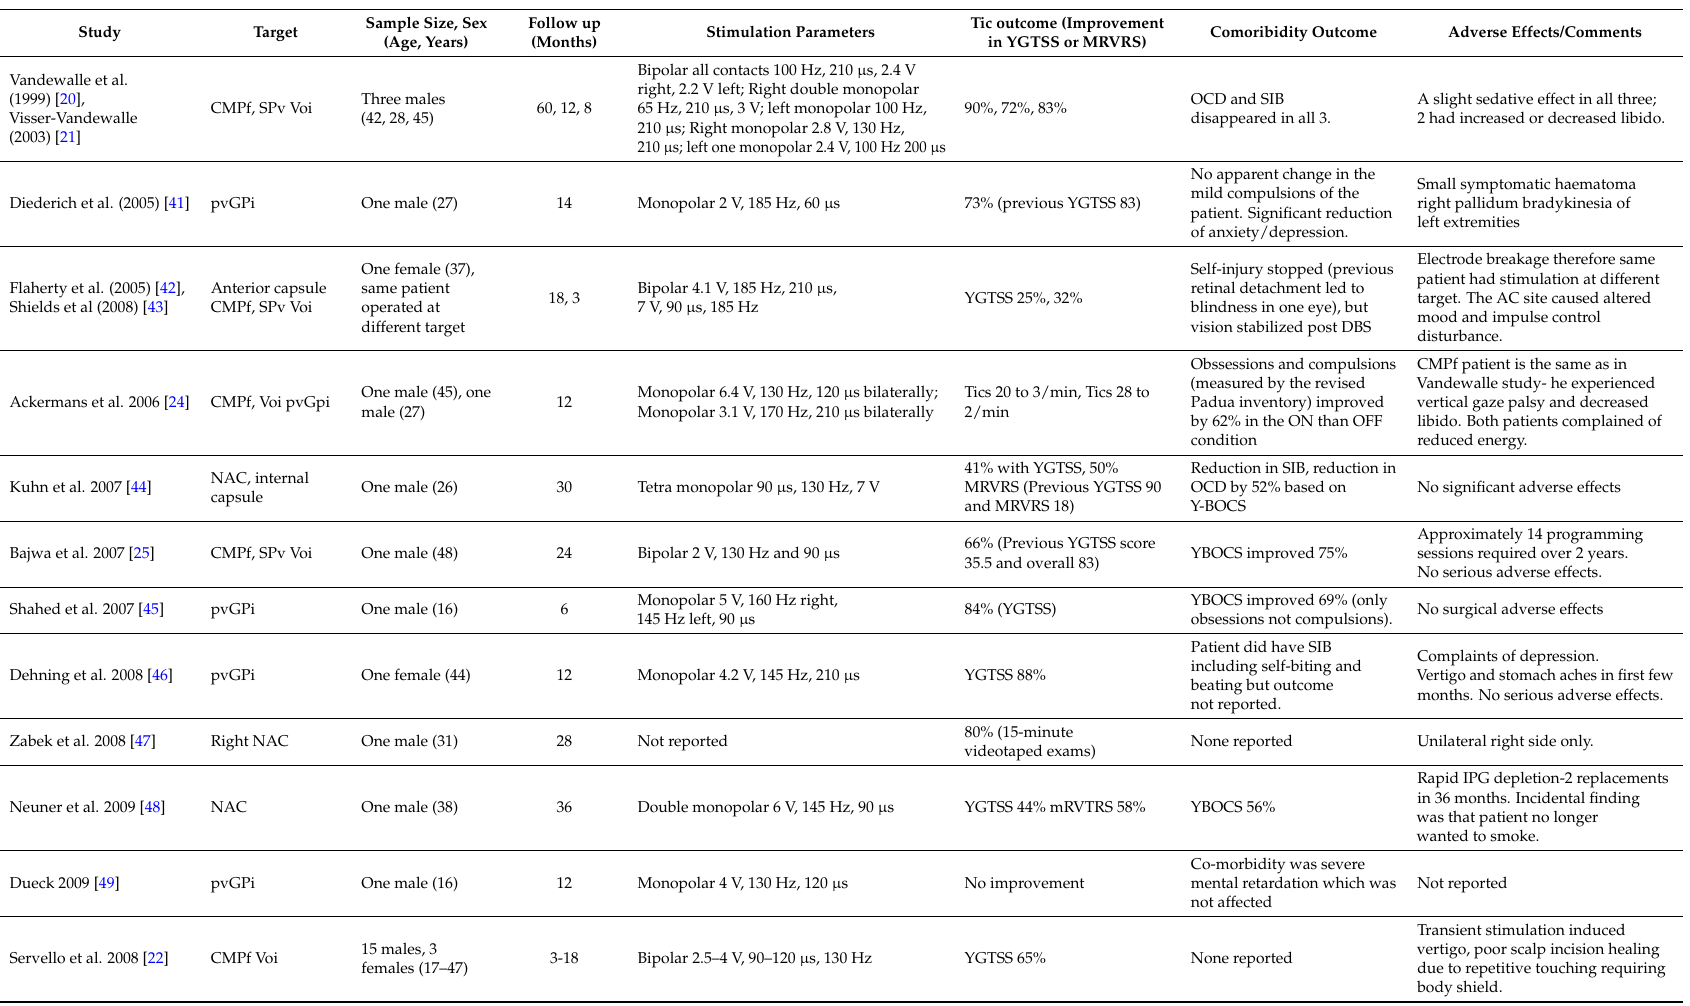
Table 1. Summary of open label